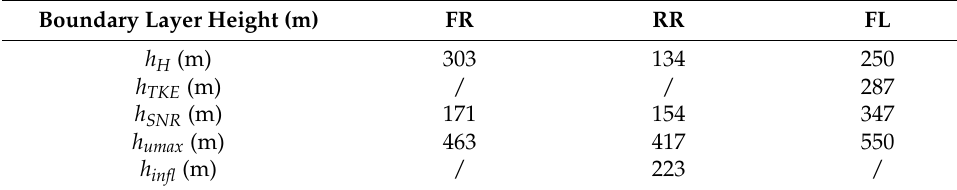
Figure 10. Variation of BLH with time calculated for B_5 using five methods. Table 5. Mean values of BLHs when B_5 is in different quadrants of the typhoon center.